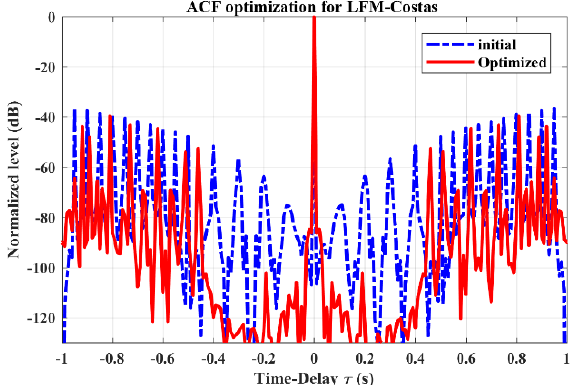
Figure 4. The Auto-Correlation Function (ACF) optimization for LFM – Costas pulse train. The blue dotted line represents the initial LFM-Costas in Figure 1b. The solid red line represents the optimized LFM-Costas in Figure 3. Here, the ACF levels are normalized and expressed in dB as ()() 10 l og m a x RR . 10